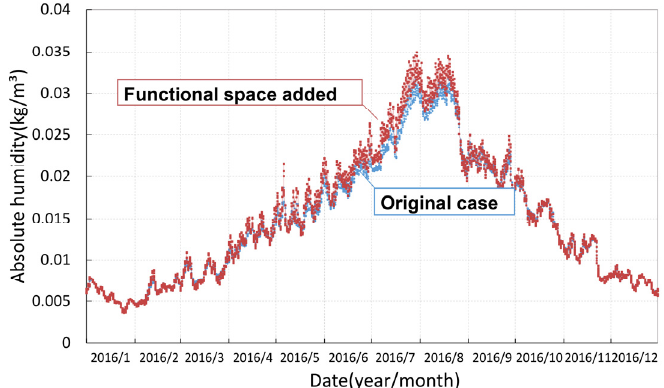
Energies 2020 , 13 , x FOR PEER REVIEW Figure 19. Comparison of relative humidity. Figure 19. Comparison of relative humidity. Table 4. Statistics of relative humidity in the tomb chamber.